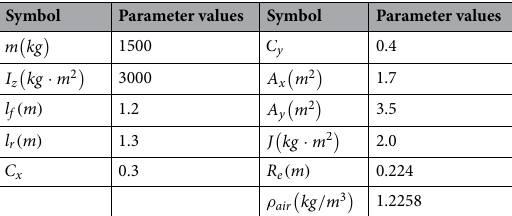
Table 1. Structural parameters of vehicle.